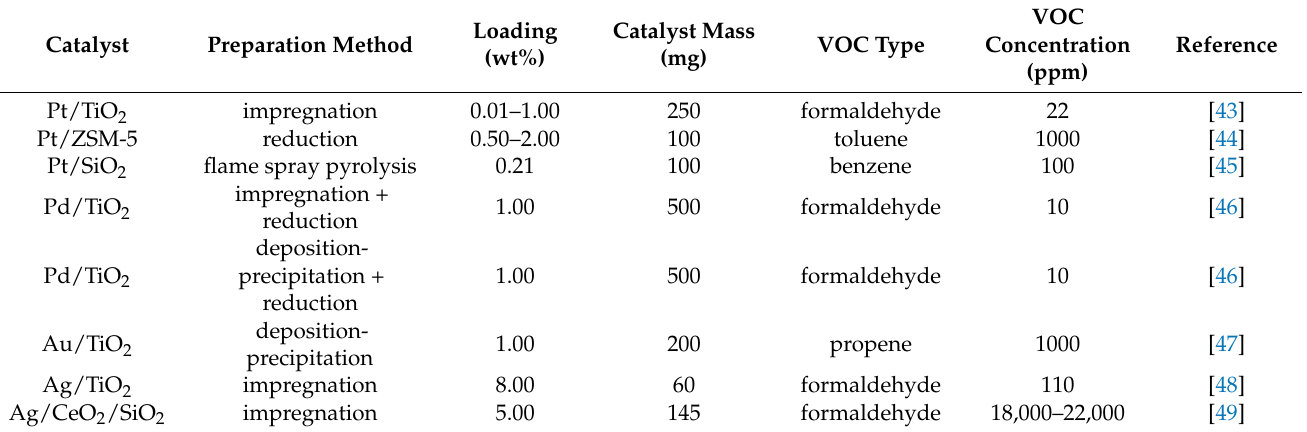
Table 2. Noble metal-based nano-catalysts for VOCs